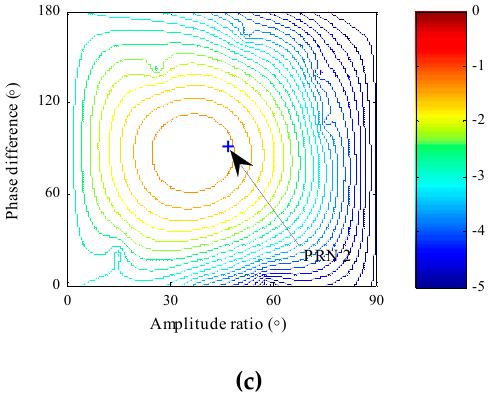
Figure 5. Array patterns when parameters are respectively fixed as those of the two desired BD2 signals using the proposed STPAP beamforming algorithm. ( a ) Beam forms in the space domain and time domain towards the two BD2 signals. ( b ) Beam forms in the polarization domain towards the BD2 signal of PRN 1. ( c ) Beam forms in the polarization domain towards the BD2 signal of PRN 2.